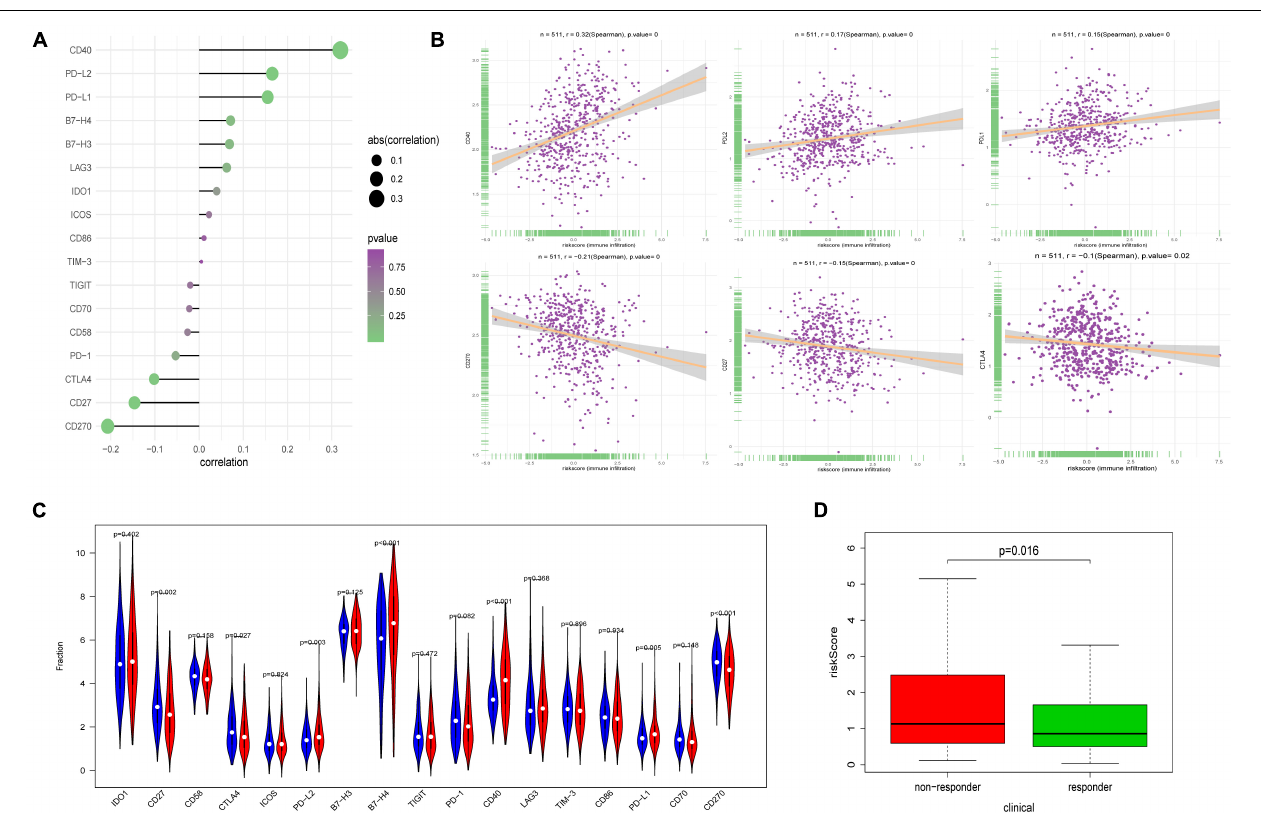
FIGURE 7 | Correlation between FRPS and immune checkpoint molecules and the predicted response to immunotherapy. (A) The association between FRPS and immune checkpoint molecules. (B) The association between FRPS and several immune checkpoint molecules in detail. (C) The landscape of the expression